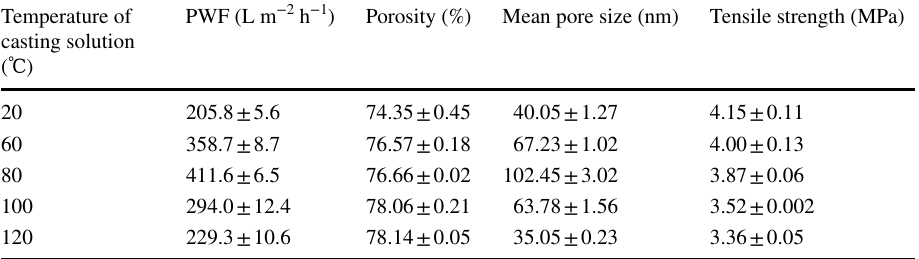
temperature of casting solution on the PWF, porosity and tensile strength of